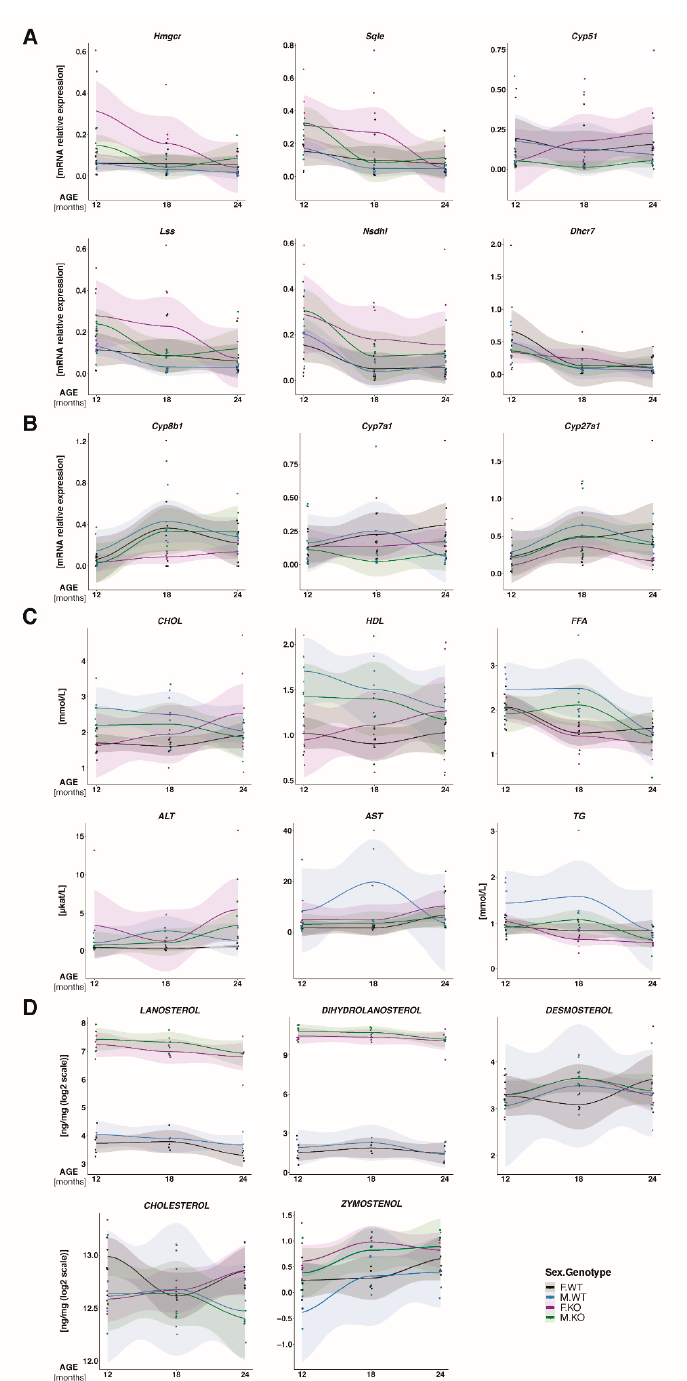
Figure 3. Adaptation to hepatocyte block in cholesterol synthesis during aging. Measurements were performed in KO and WT mice at 12M, 18M and 24M of age. Expression of hepatic genes from ( A ) from cholesterol synthesis ( B ) and bile acid synthesis. N = 5 mice per sex / genotype / age group. ( C ) Plasma concentration of biochemical parameters, N = 5–10 mice per sex / genotype / age group. CHOL—cholesterol, HDL—high-density lipoproteins, FFA—free fatty acids, ALT—alanine aminotransferase, AST—aspartate aminotransferase. ( D ) Liver concentration of sterol intermediates and cholesterol, N = 4–6 mice per sex / genotype / age group. Light color bands—95% confidence interval. Dots—individual measurements. KO, Cyp51 KO; WT, Cyp51 WT, F = female; M =